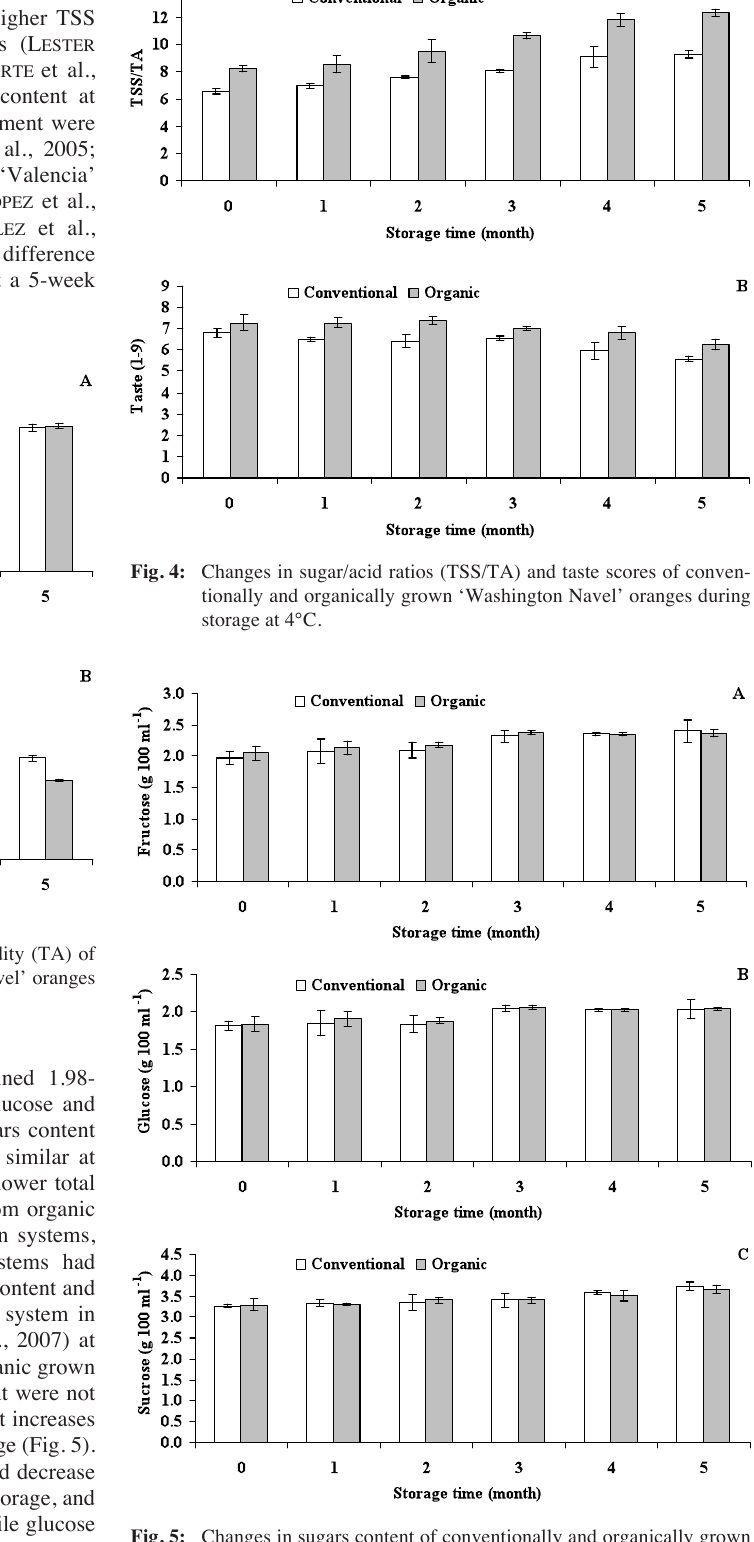
Fig. 5: Changes in sugars content of conventionally and organically grown ‘Washington Navel’ oranges during storage at 4°C. (1990), the increase in sugar concentration (due mainly to sucrose) accounted for the measured rise in TSS content for ‘Hamlin’ orang-